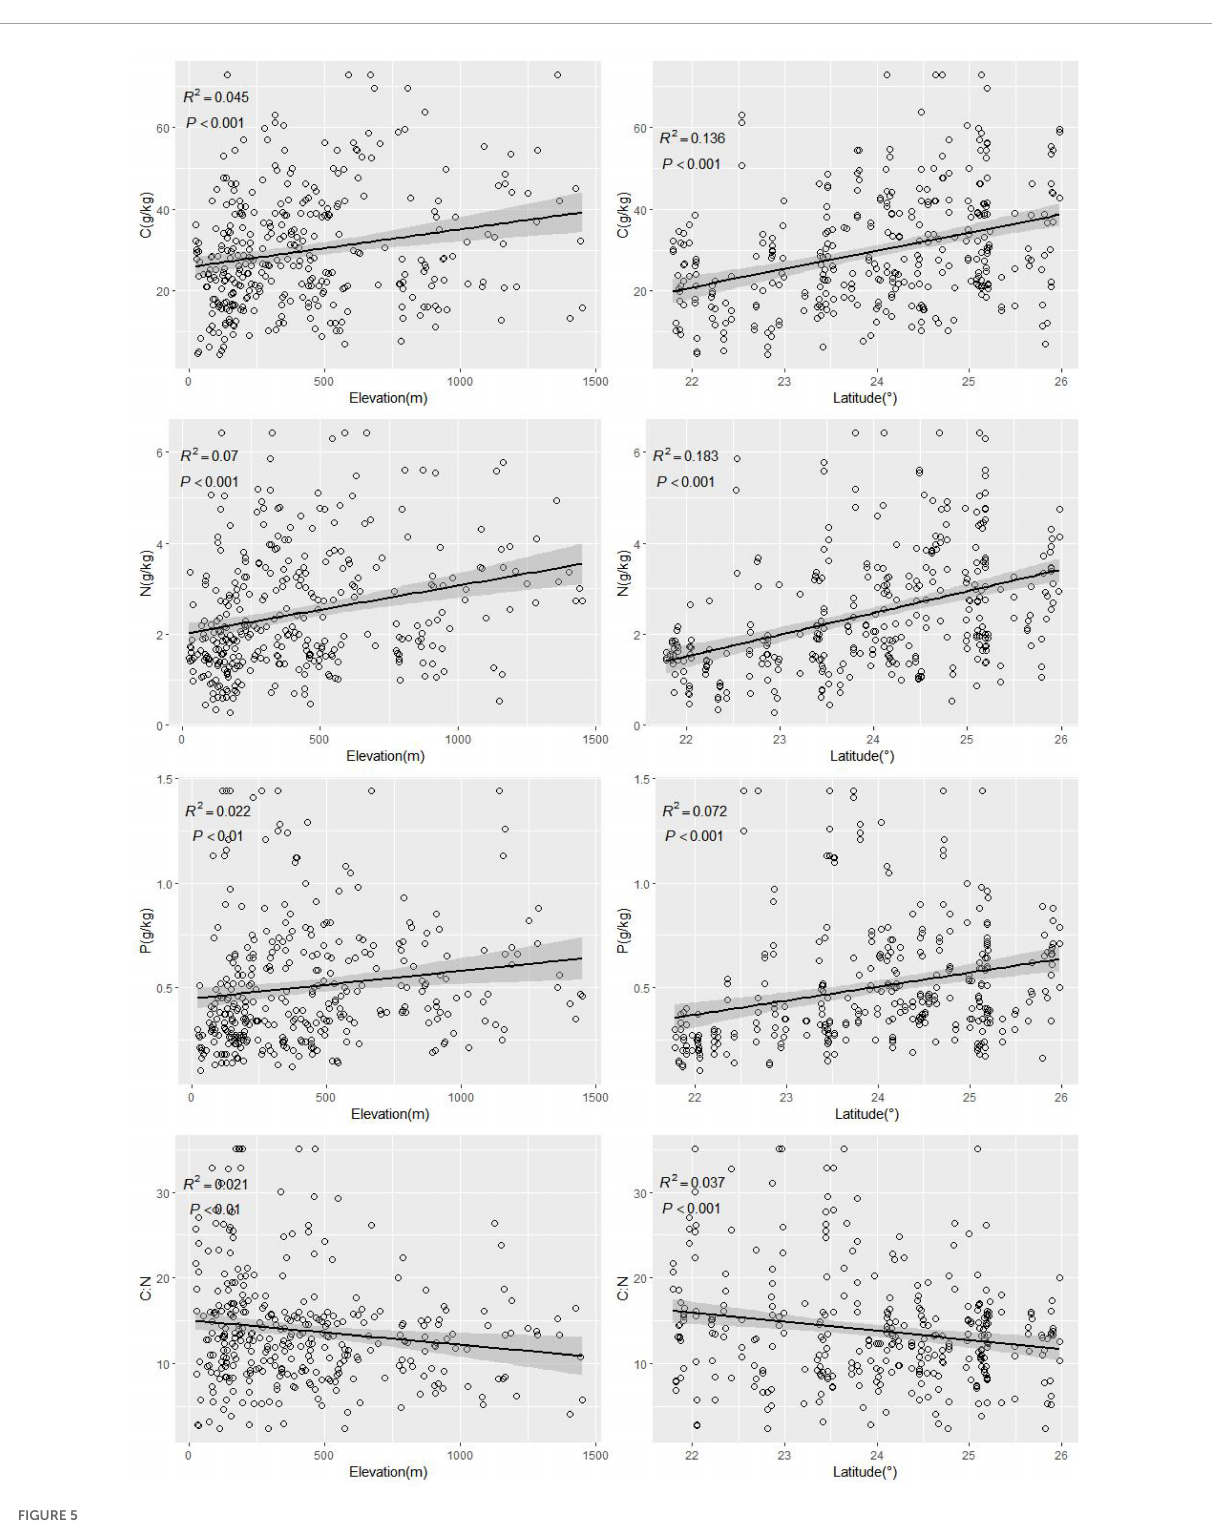
FIGURE5 Significant relationships between soil C, N, P, C:N and elevation,